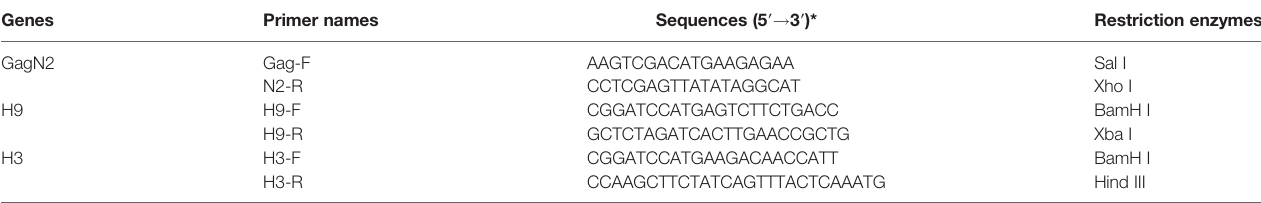
TABLE 1 | The information of primers used to amplify the GagN2, H9, and H3 genes in order to construct the recombinant pFastBac1 plasmids.